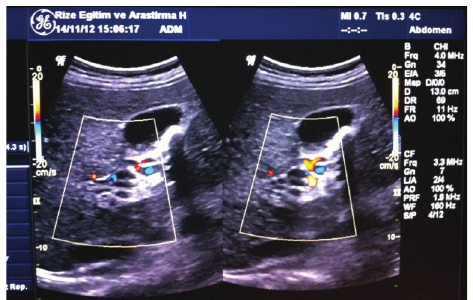
Figure 1: Multiple serpiginous venous collaterals with turbulent venous flow around the thin thrombosed portal vein consistent with cavernous transformation of the portal vein can be seen in the color Doppler ultrasound